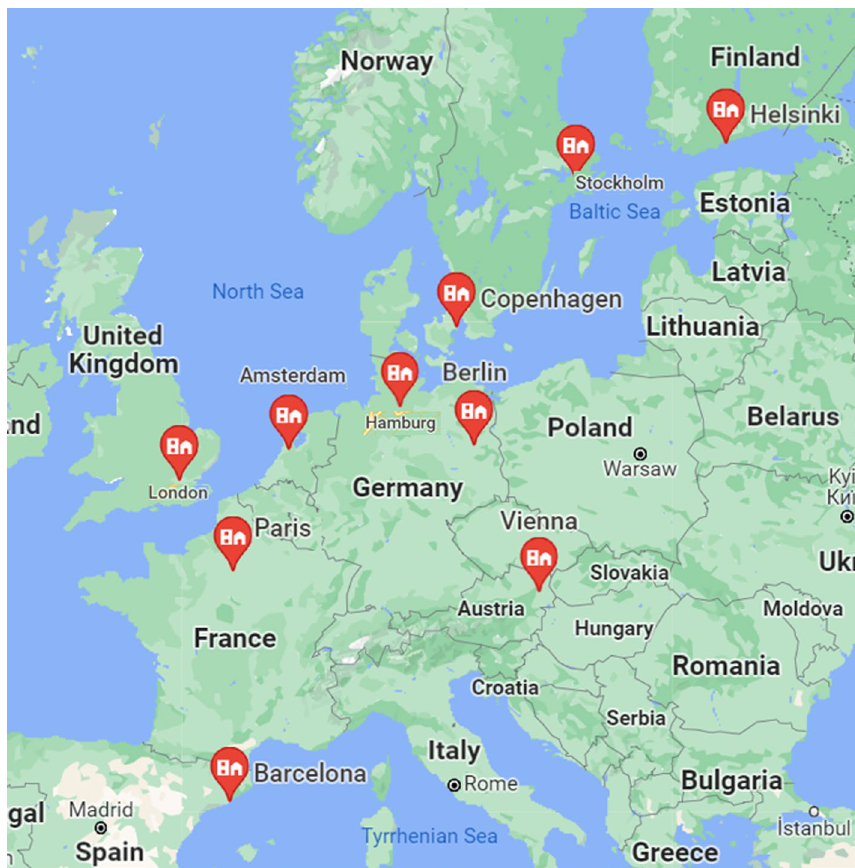
Fig. 2 Top ten European smart cities in 2020. Source : Wilson